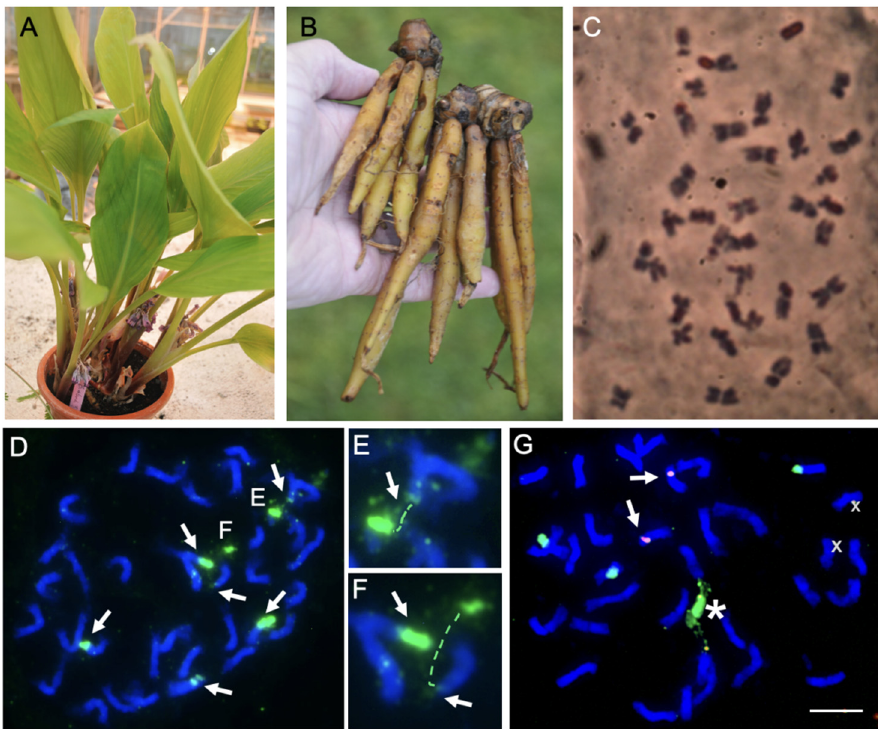
Figure 1. Boesenbergia rotunda leaves, rhizomes and number and location of 45S and 5S rDNA sites on metaphase chromosomes (2n = 36). ( A ) Leaves. ( B ) Rhizomes. ( C ) Chromosome preparation using fresh root tips. ( D – G ) Fluorescent in situ hybridization with clone pTa71 (45S rDNA of wheat), labelled with digoxigenin and detected with FITC (green) and clone pTa794 (5S rDNA of wheat) labelled with biotin and detected with Alexa 674 (shown in red). ( D – F ) early metaphase showing six sites of 45S rDNA (arrows) of variable strength at ends of 3 pairs of chromosomes. In some cases, the rDNA is extended, and the satellite is separated from the main chromosomes shown enlarged in ( E , F ). ( G ) Two 5S rDNA sites (arrows) were detected on a chromosome pair not bearing 45S rDNA. The star indicates the fusion of 2 or 3 45S rDNA sites.